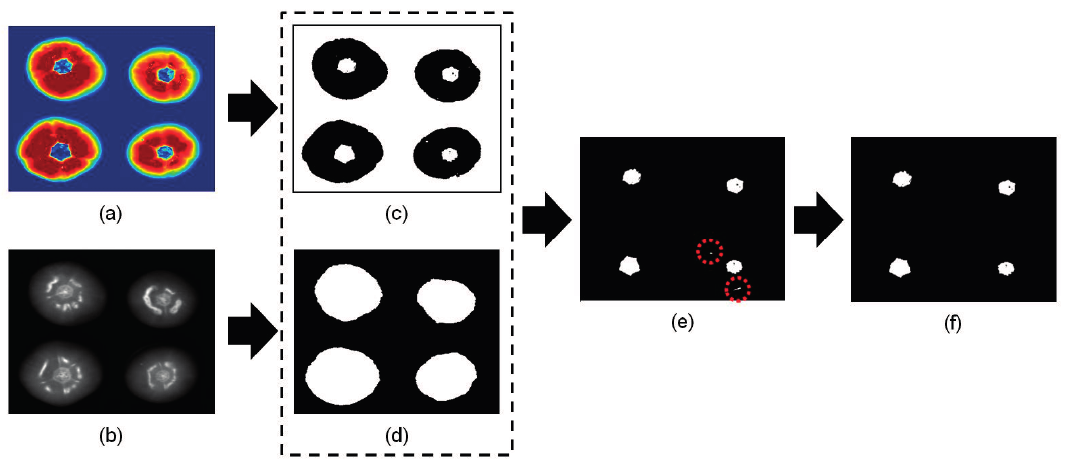
Figure 6. The sequence of events followed during image processing of the sound tomato. ( a ) Example of a PLS-DA image obtained using the re-developed model. ( b ) A single wavelength (1098 nm) masking image. ( c ) A PLS-DA binary image obtained using a threshold value of 0.5. ( d ) Masking image. ( e ) The image obtained by combining the PLS-DA binary image (c) with the masking image (d). ( f ) The final image obtained after removal of scattered